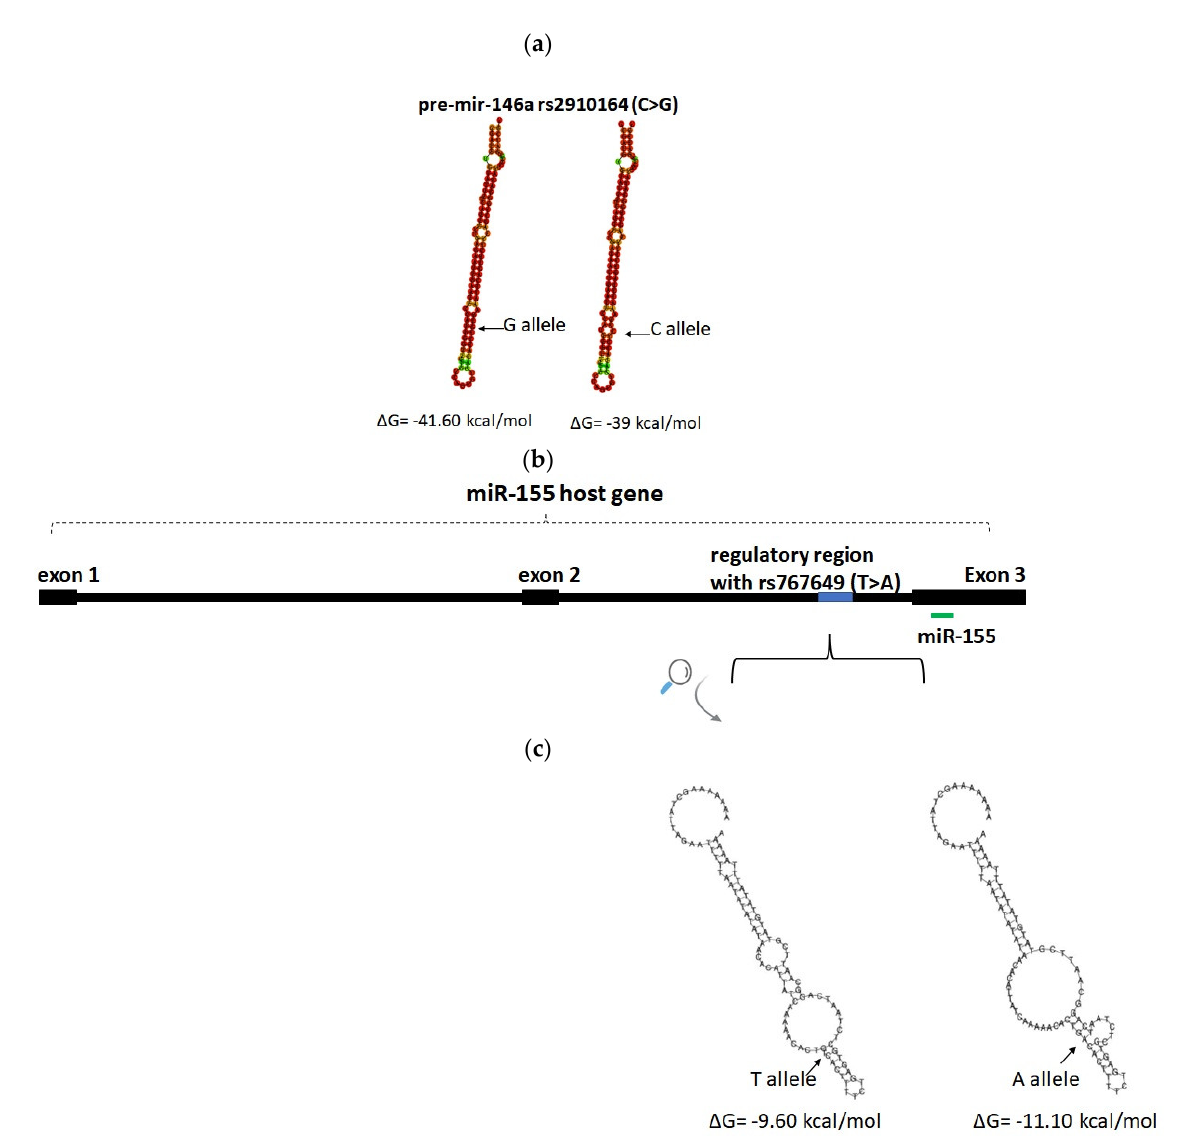
Figure 4. The impact of rs2910164 (C>G) in the secondary structure and minimum free energy of pre-miR-146a, as predicted by RNAfold Web Server ( a ). Genomic location of rs767649 (T>A) in a regulatory region of miR-155 ( b ) and impact of the polymorphism in the secondary structure of single-stranded DNA, as predicted by VectorBuilder ( c ) .